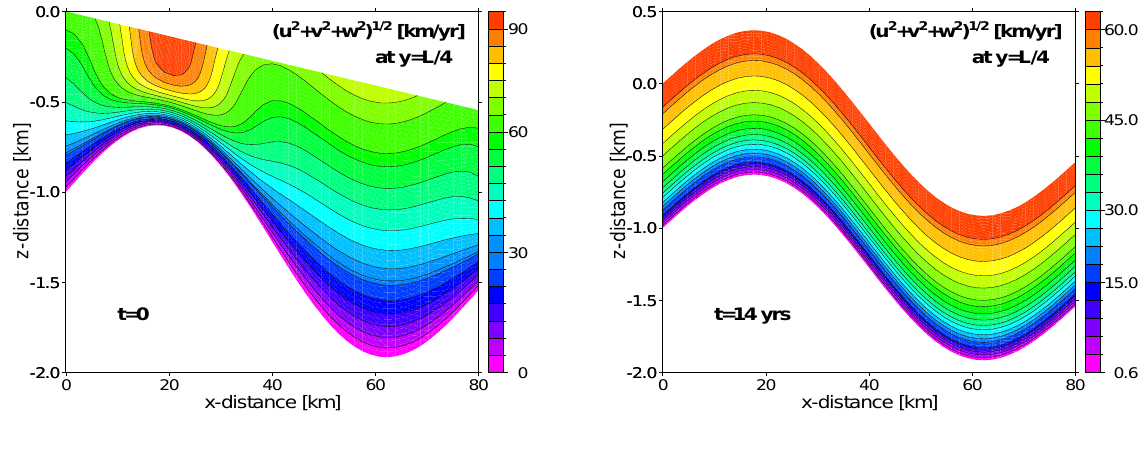
(cid:16) (cid:17) 1 / 2 u 2 + v 2 + w 2 along the y = 1 / 4 slide at the